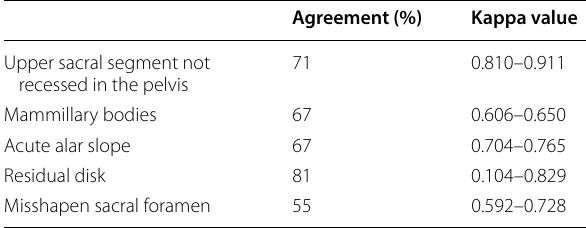
Table 3 Interrater